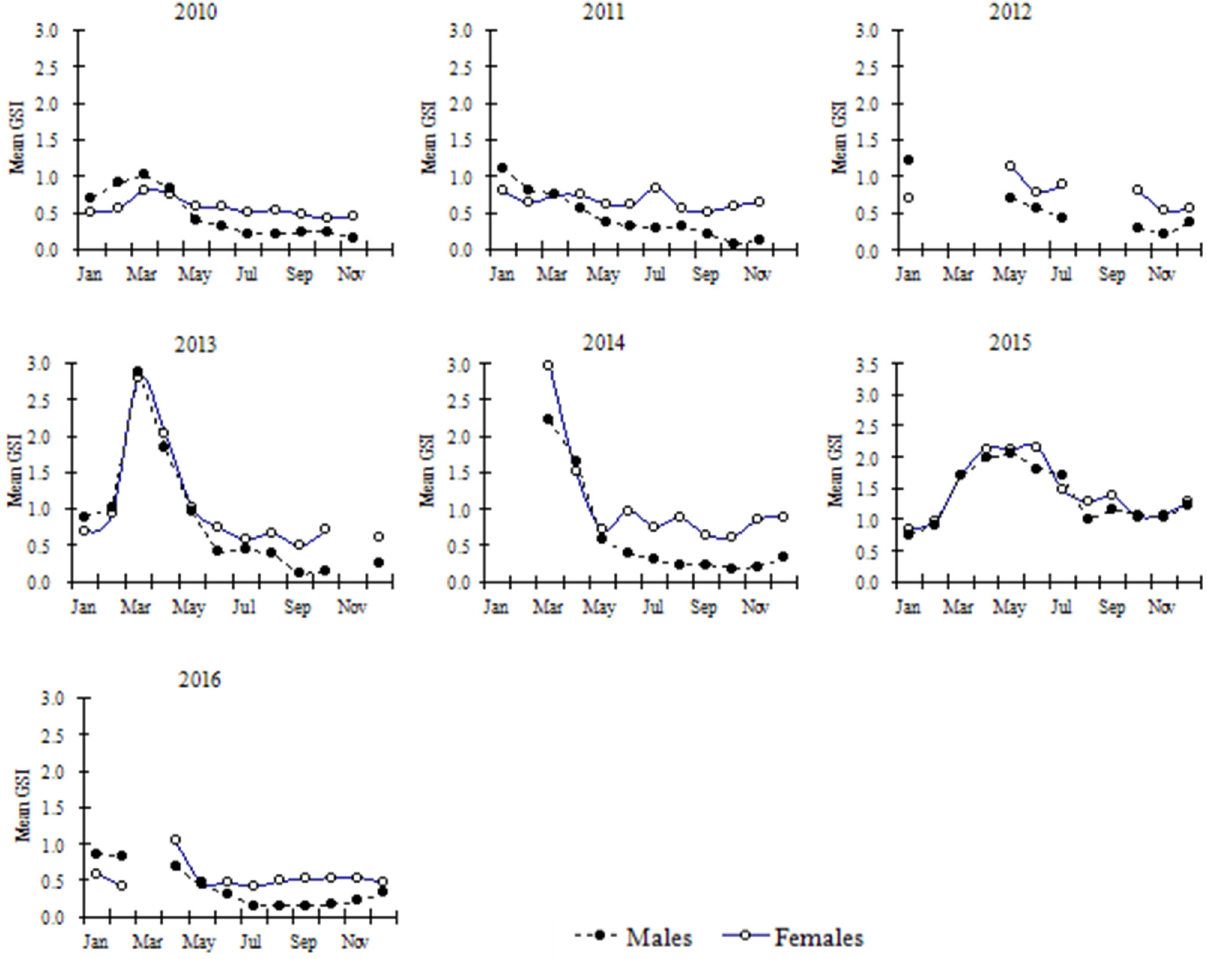
Fig. 6. Mean monthly gonadosomatic indices (GSI) (males and females) for T. picturatus from north-east Atlantic waters (Portuguese